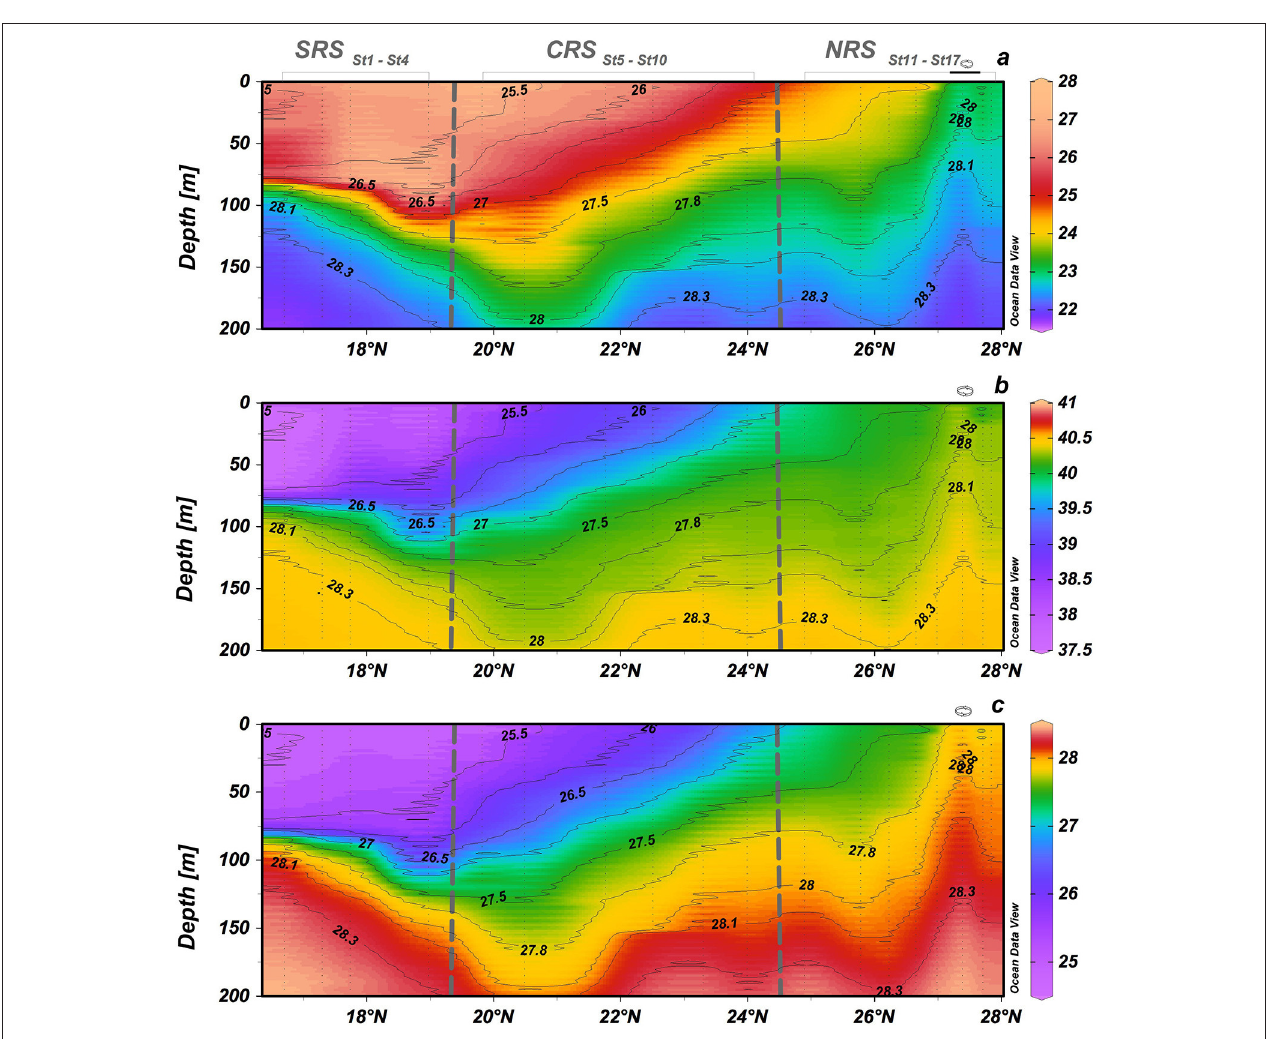
FIGURE 2 | Hydrographic section along the south-north transect in the 0–200 layer. (a) Potential temperature ( ◦ C), (b) salinity, and (c) potential density (kgm − 3 ). The contour lines in each plot are density isopycnal surfaces. Eddy stations marked along the top of the upper